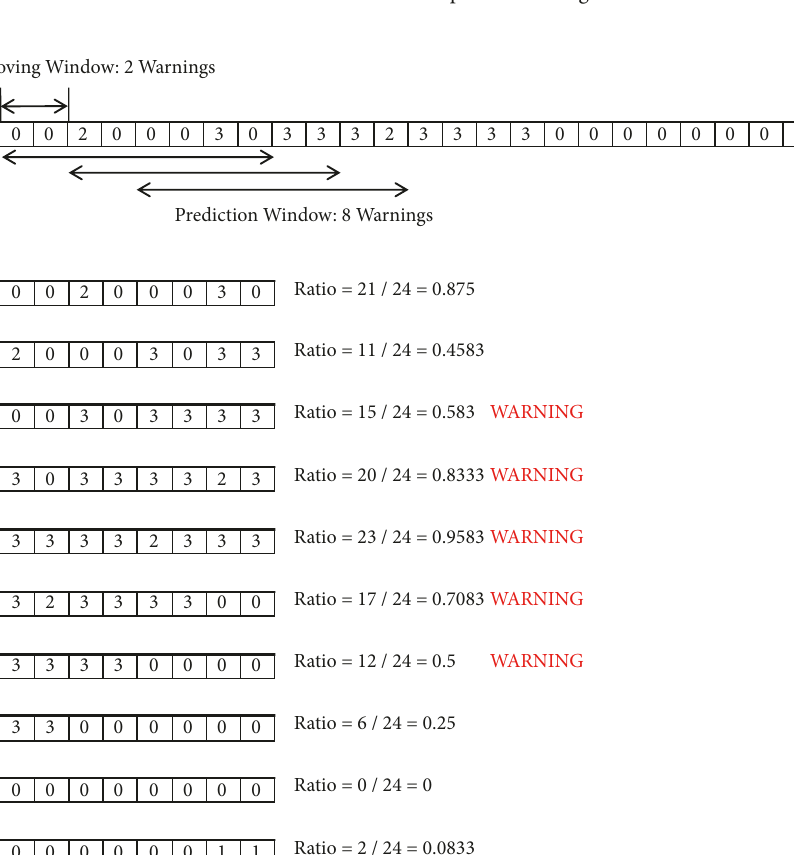
Figure 15: Illustration of sample and moving windows.